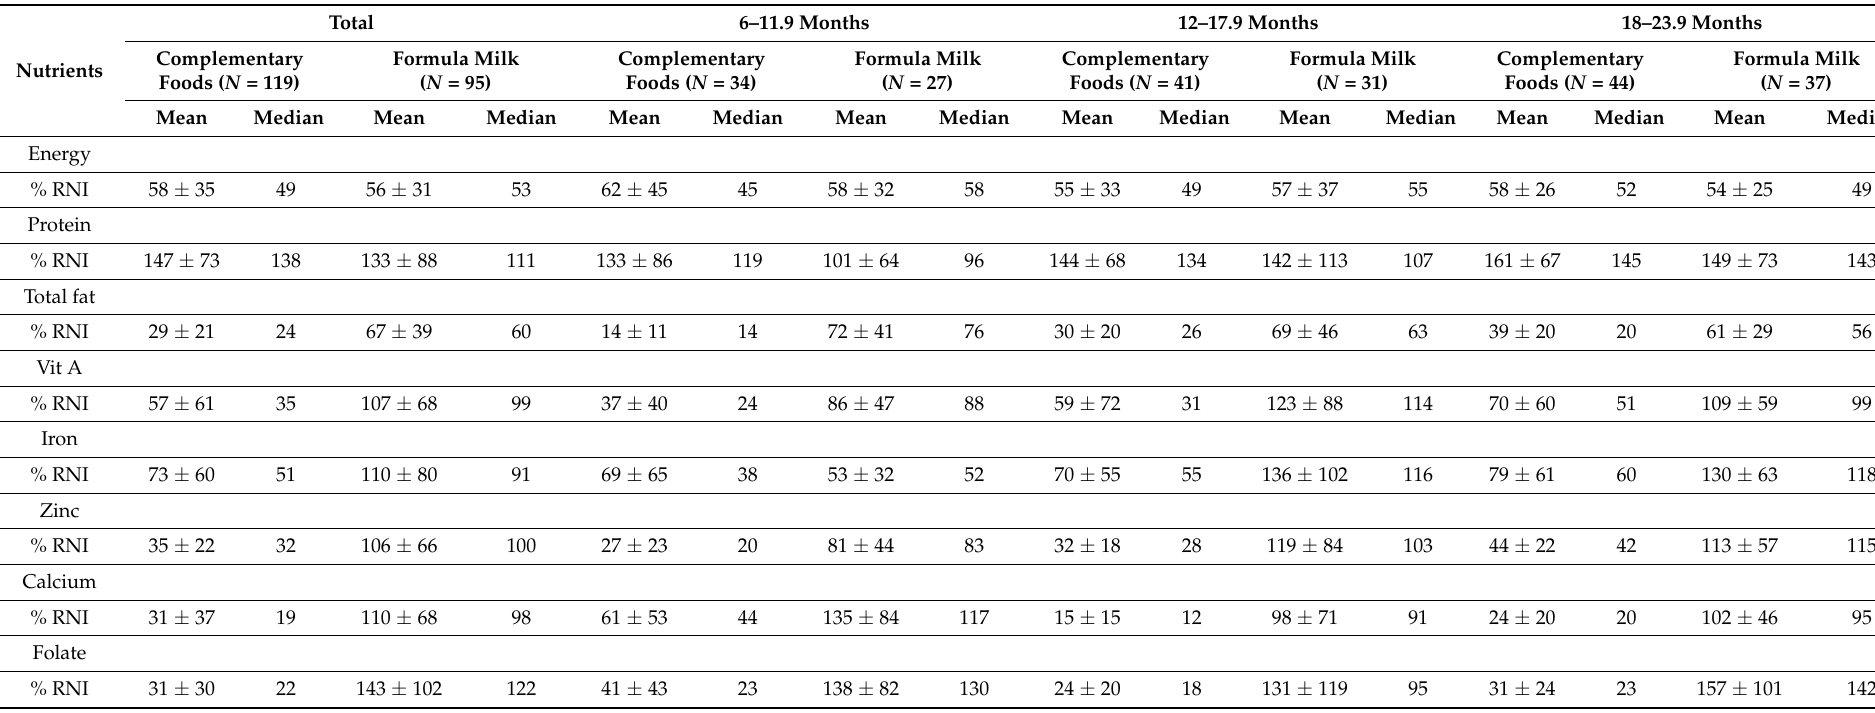
Table 8. Comparing intake of energy and nutrients from complementary foods and milk-based formulas in terms of contributions to recommended intake (RNI) by age group ( N =